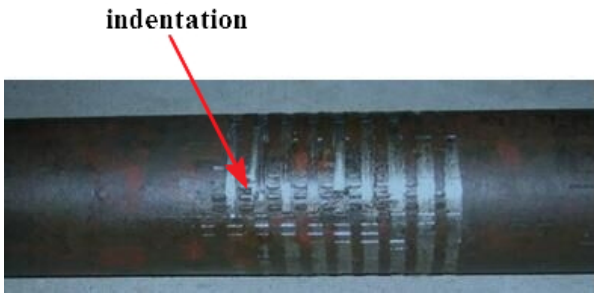
Figure 2. Indentation on the surface of the casing.